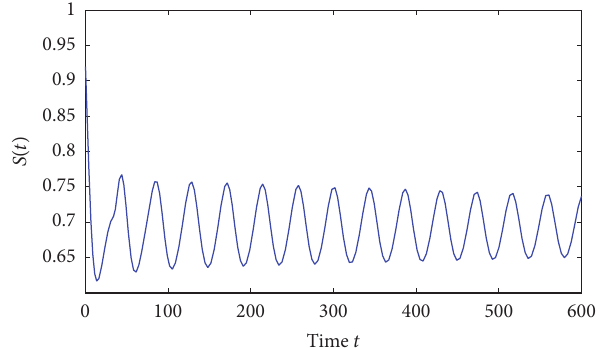
Figure 3: 𝐸 + loses stability and a Hopf bifurcation occurs when 𝜏 = 0.92, 0.155, 0.112 .” 32.8965 > 𝜏 0 with initial value “